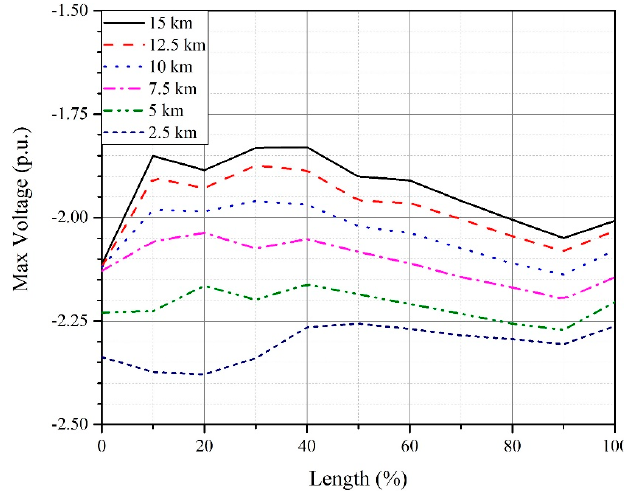
Figure 23. Core-ground overvoltage along the length of the cable with a surge arrester installed at the terminals.